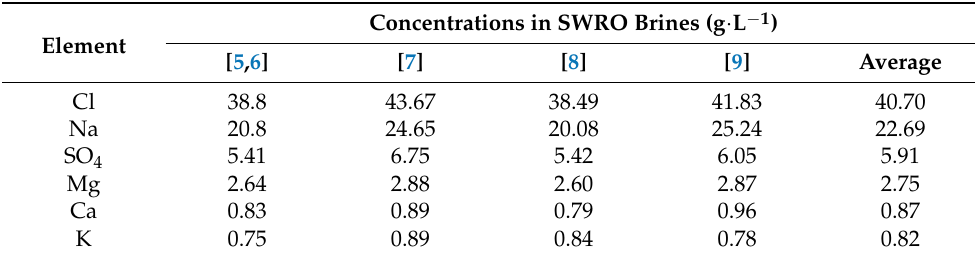
Table 1. Average concentrations of major elements present in SWRO brines reported in literature.